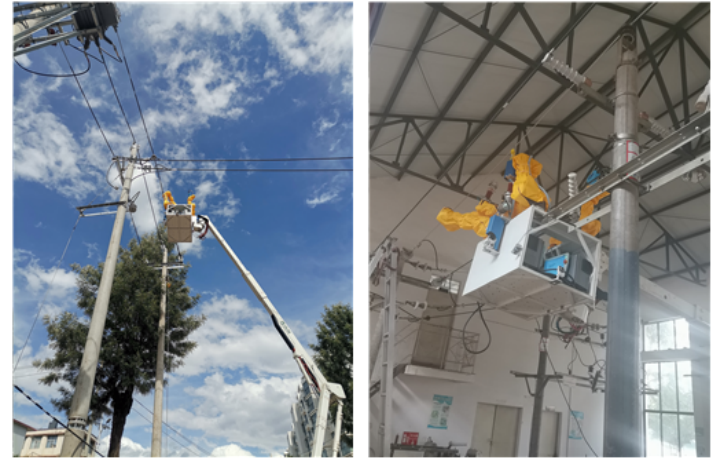
Figure 22. Simulated experiment